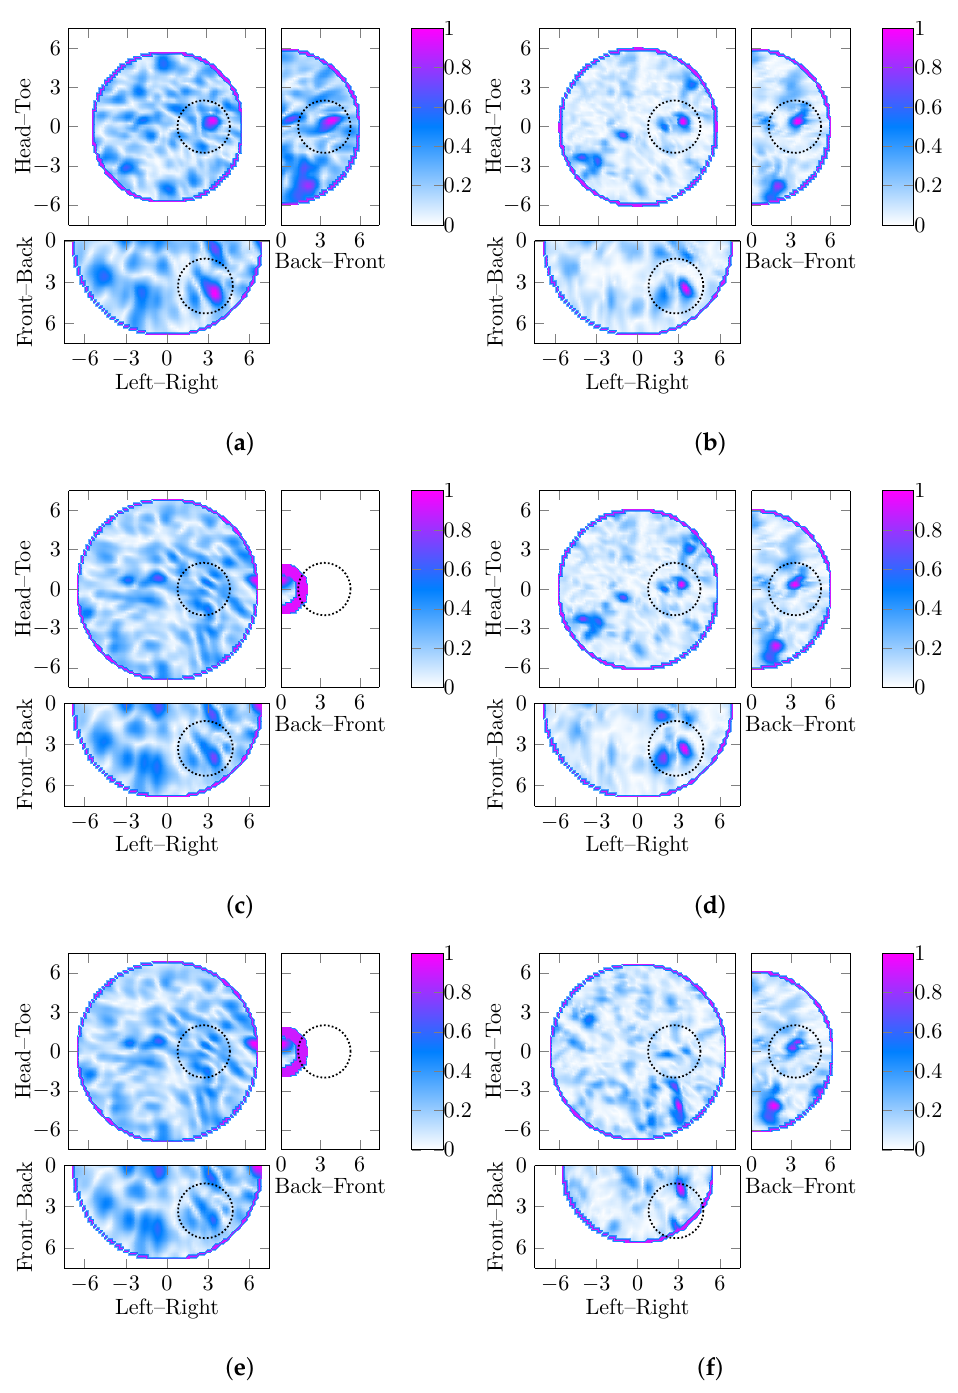
Figure 3. Six images of a 2cm diameter tumor in the breast phantom with 20% VGF are shown, reconstructed with the DAS and DMAS beamformers are three different reconstruction permittivities. The DAS images are shown in the leftmost column in order of increasing permittivity, similarly, the corresponding DMAS images are shown in the rightmost column. Depending on the reconstruction permittivity chosen between ε r = 11.75 and ε r = 12.75, both beamformers perform the same and correctly localize the tumor in ( a ) and ( b ), DMAS outperforms DAS in ( c ) and ( d ), or neither DAS nor DMAS localize the tumor in ( e ) and ( f ). All dimensions are in cm, and the three slices shown (coronal, sagittal and axial) are cross-sections at the location of the maximum amplitude of the image in each